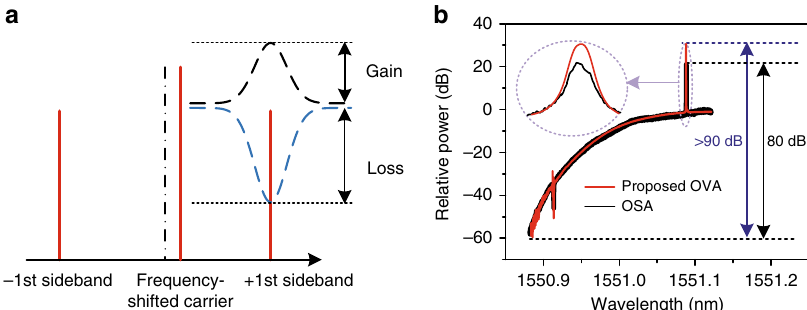
Fig. 6 The dynamic range of the proposed OVA. a The illustration of the dynamic range. The dynamic range is the difference between the smallest and largest probe signal that can be detected by the ASR. b The magnitude response with >90-dB dynamic range measured by the proposed OVA (red line) and an OSA with 80-dB dynamic range (black